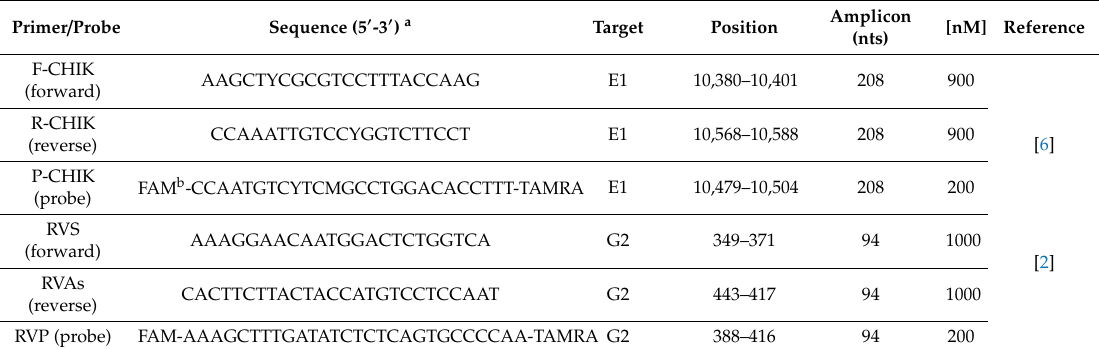
Table 1. Oligonucleotide primers and probes used in this